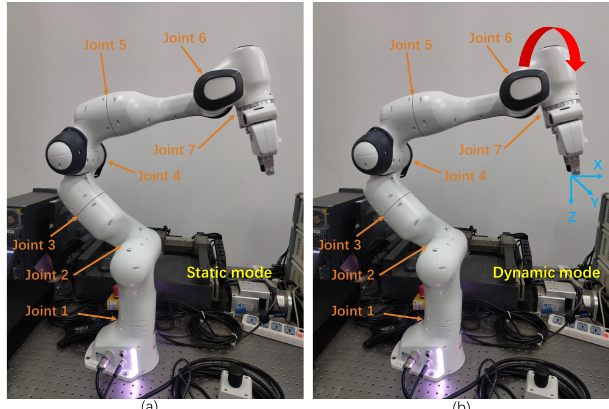
Figure 7. Two motion modes in the TVDT model identification experiment. ( a ) Stationary mode; ( b ) Dynamic mode.